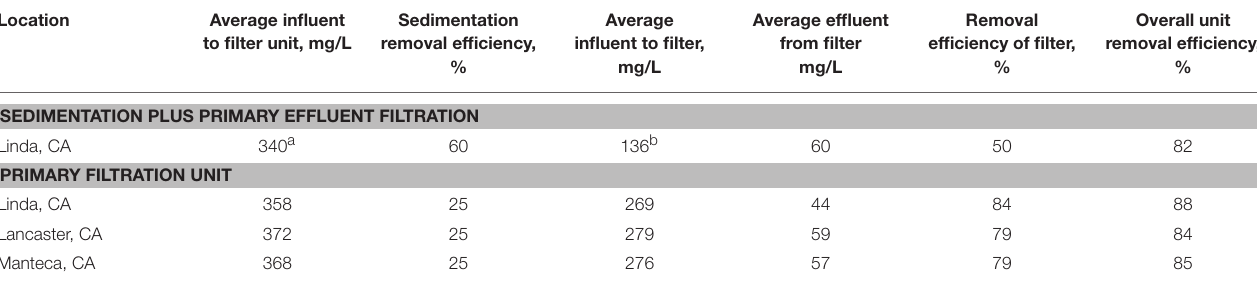
TABLE 2 | TSS removal performance using cloth disk filter for primary effluent and primary filtration. Location Average influent